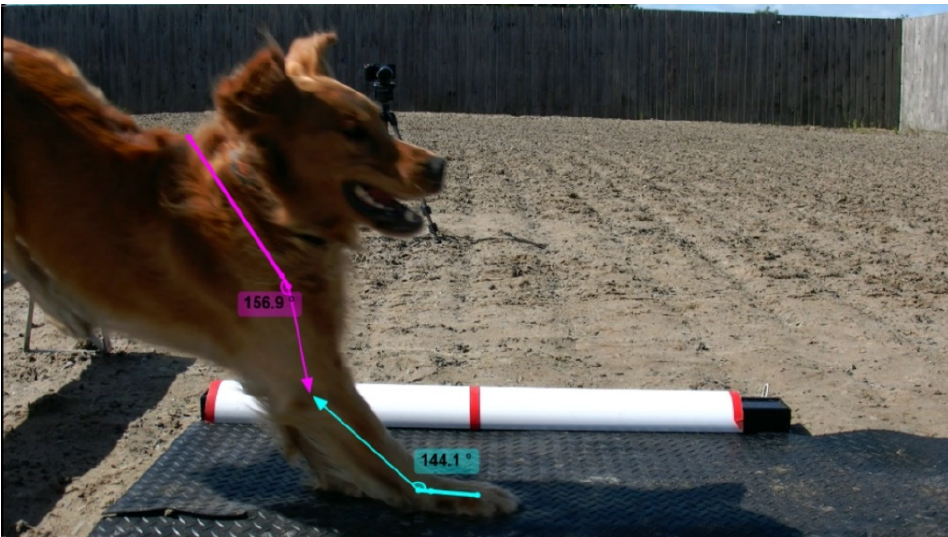
Figure 3. Apparent angles of the carpus (green angle line) and shoulder (pink angle line) of dogs on landing after clearing the long jump, measured using Kinovea Version 0.9.3 (www.kinovea.org.uk, accessed on 10 June 2021).